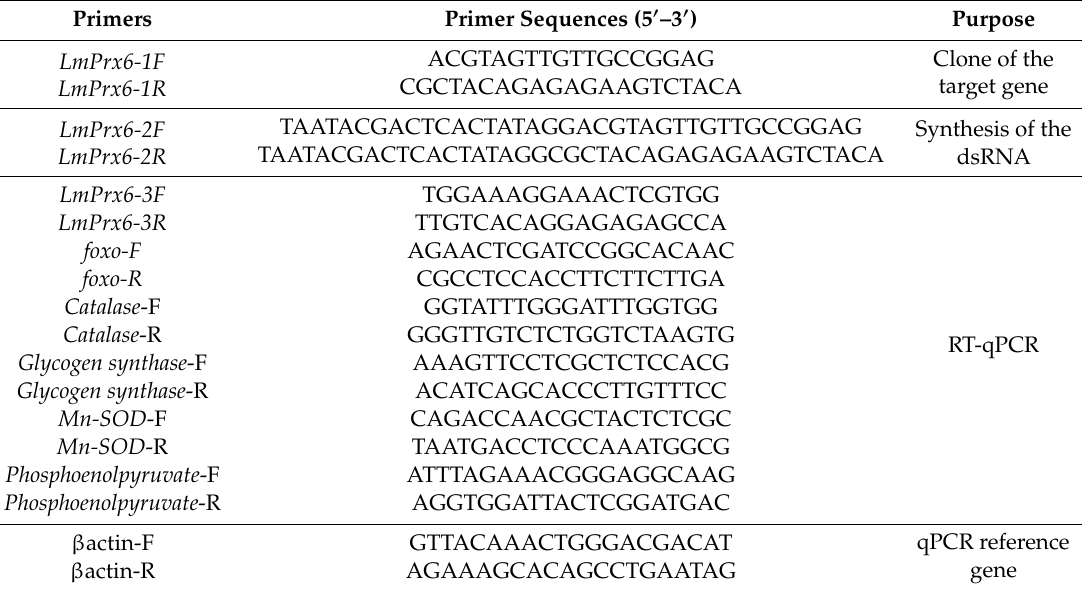
Table 1. List of specific primers used and synthesized for the current